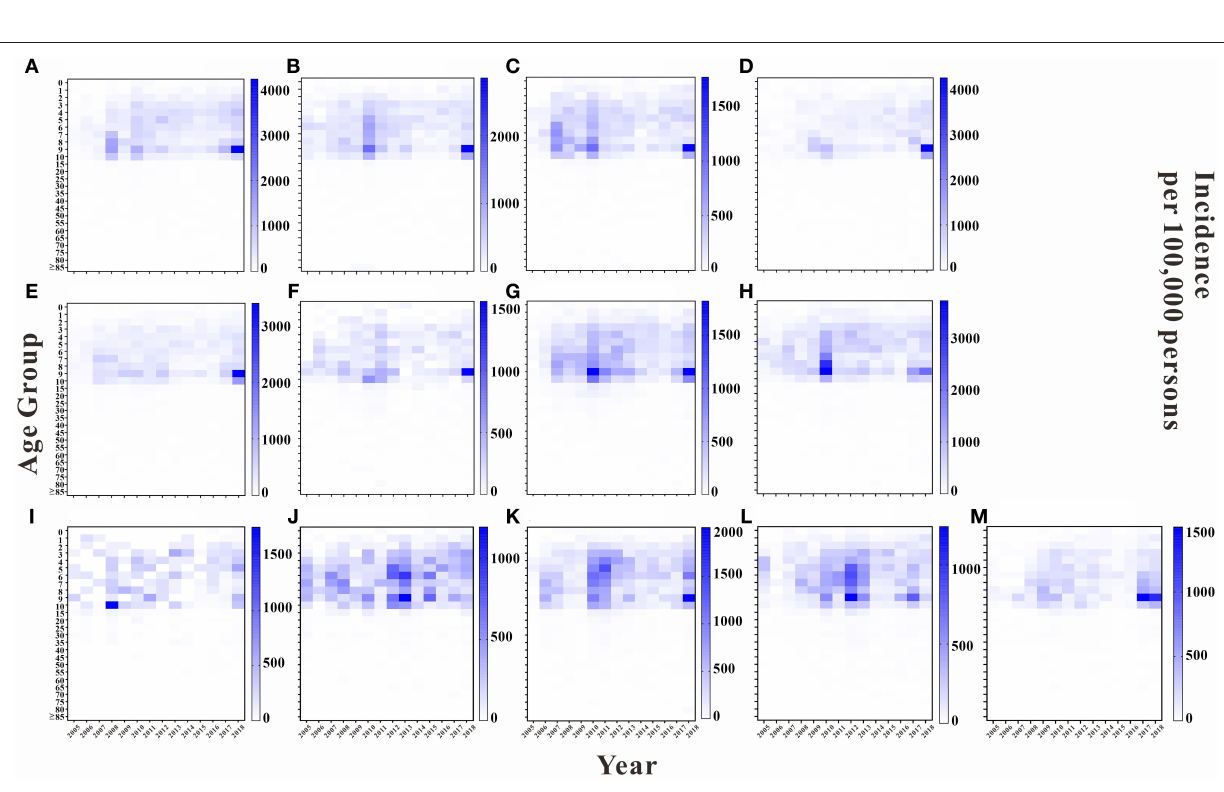
FIGURE 5 | Incidence rate of each age group in Wuhan City by region in each year. (A) Jiangan District. (B) Jianghan District. (C) Qiaokou District. (D) Hanyang District. (E) Wuchang District. (F) Qingshan District. (G) Hongshan District. (H) Dongxihu District. (I) Hannan District. (J) Caidian District. (K) Jiangxia District. (L) Huangpi District. (M) Xinzhou